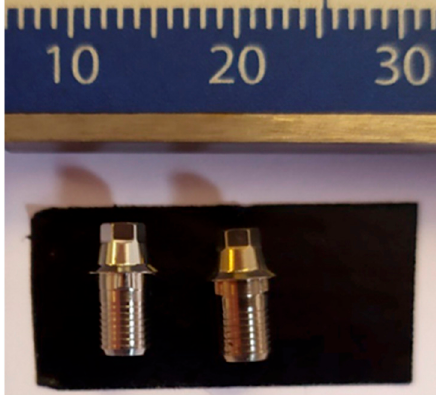
Figure 5. Control ( left ) and test ( right ) TBAs.